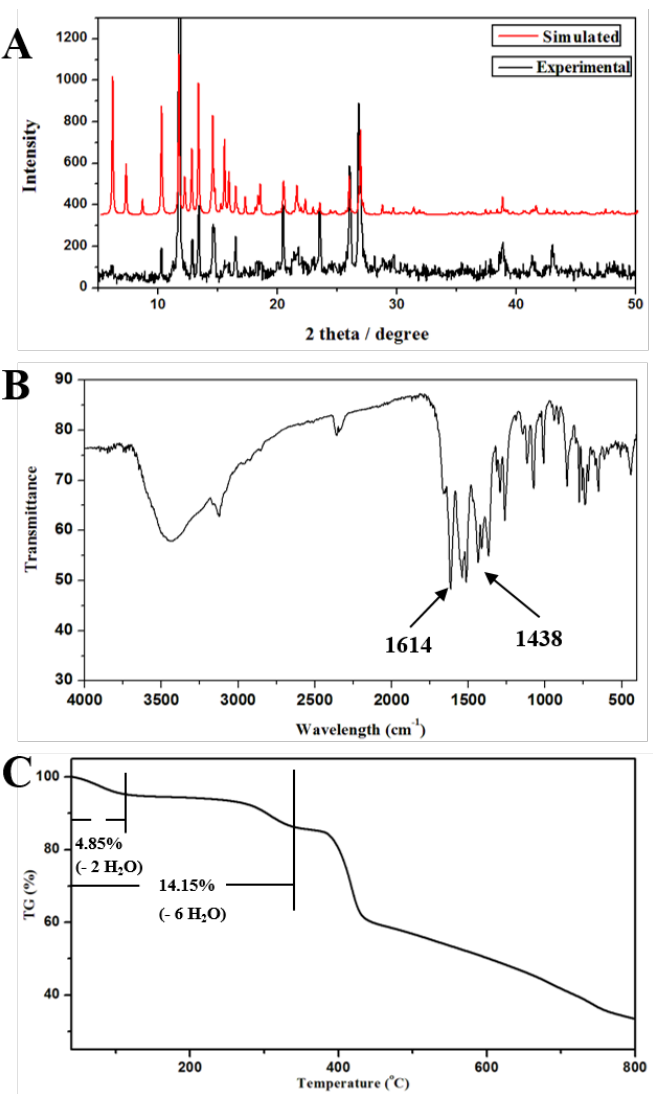
Figure 4. ( A ) FT-IR spectrum of 1 ; ( B ) the powder PXRD pattern and the simulated one from the single-crystal diffraction data of 1 ; and ( C ) TGA curve of 1 .